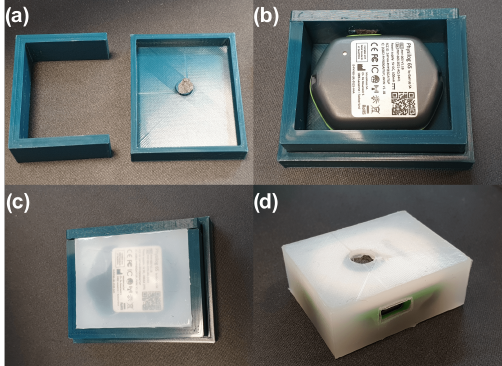
Figure 4. ( a ) 3D Printed mould. ( b , c ) P6 sensor enclosed in silicon. ( d ) Fully cured sensor